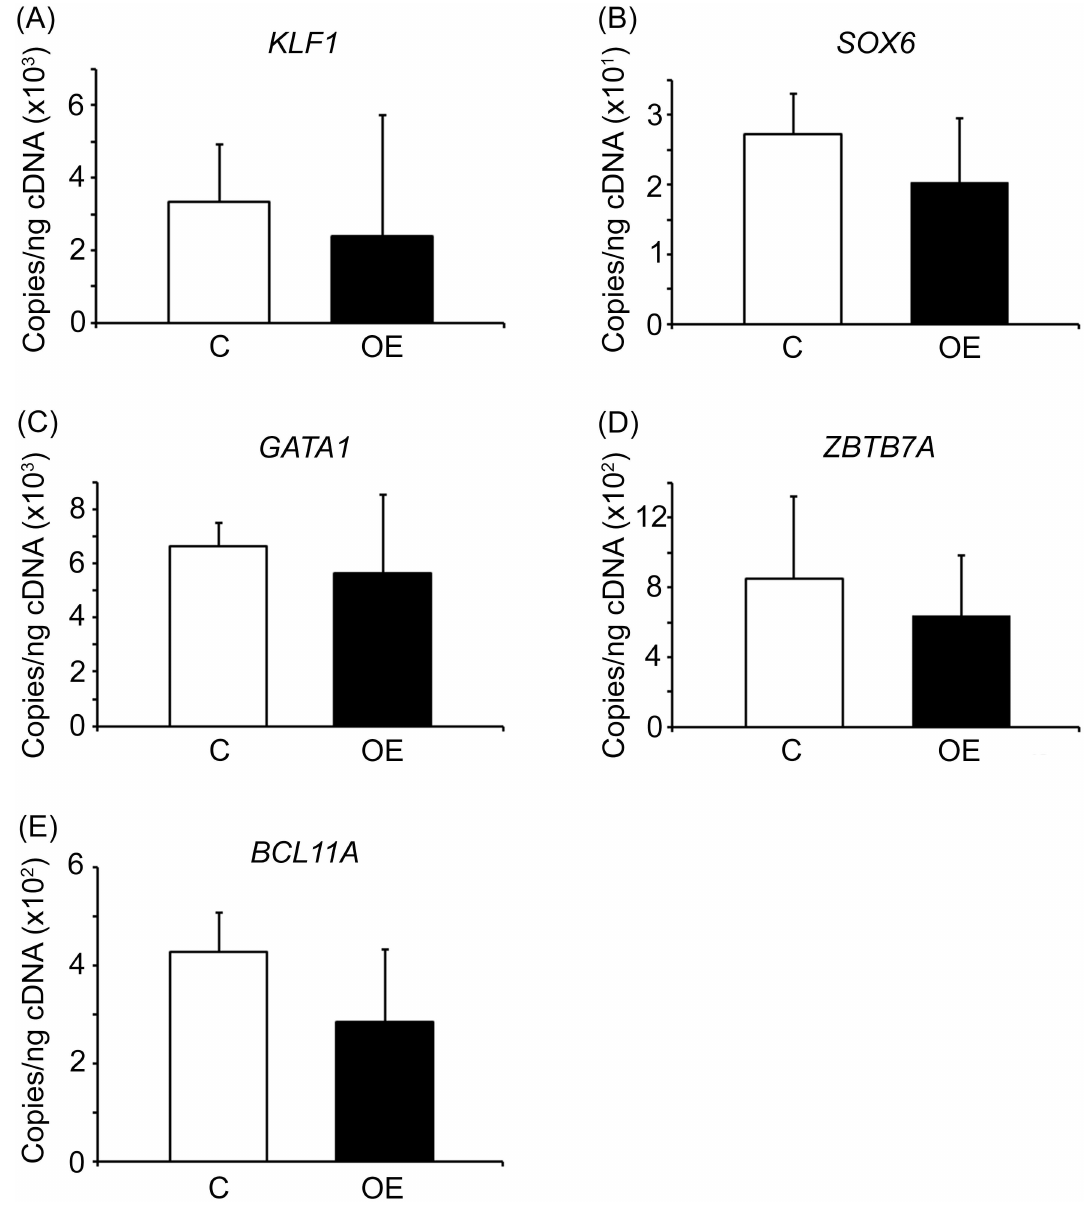
Fig 5. HMGA2 expression has mild effects in erythroid- and HbF-related transcription factors. Expression level of (A) KLF1 , (B) SOX6 , (C) GATA1 , (D) ZBTB7A and (E) BCL11A were analyzedin HMGA2-OE and empty vector control transductions. Quantitation of copy number per nanogramcDNA (copies/ngcDNA) by Q-RT-PCR analyseswas performed at culture day 14. Open bars represent empty vector control and black bars represent HMGA2-OE. Mean value ± SD of four independentdonorsfor each condition. C = empty vector control transduction; OE = HMGA2